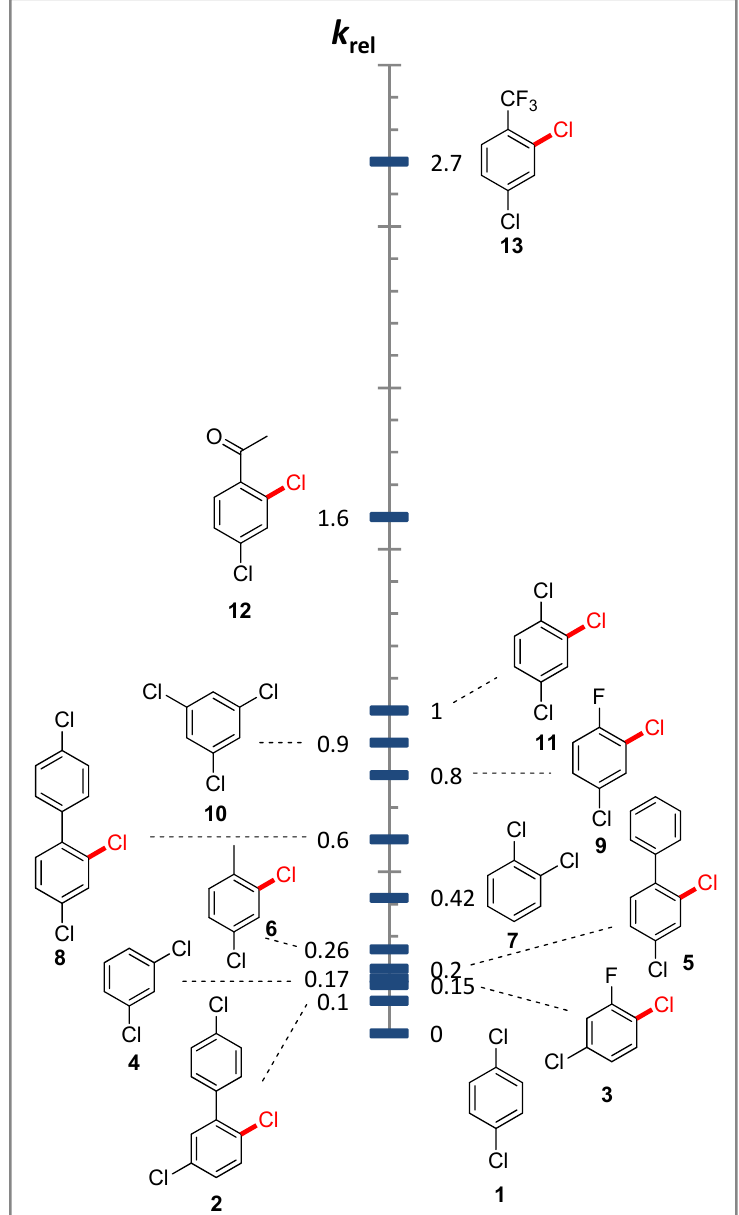
Figure 1. The relative reactivity of substituted dichlorobenzenes (C cobalt-catalysed methoxycarbonylation. The C–Cl bond which is preferentially cleaved is marked in